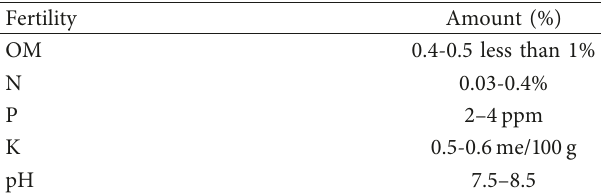
Table 8: Chemical test and soil nutrients.